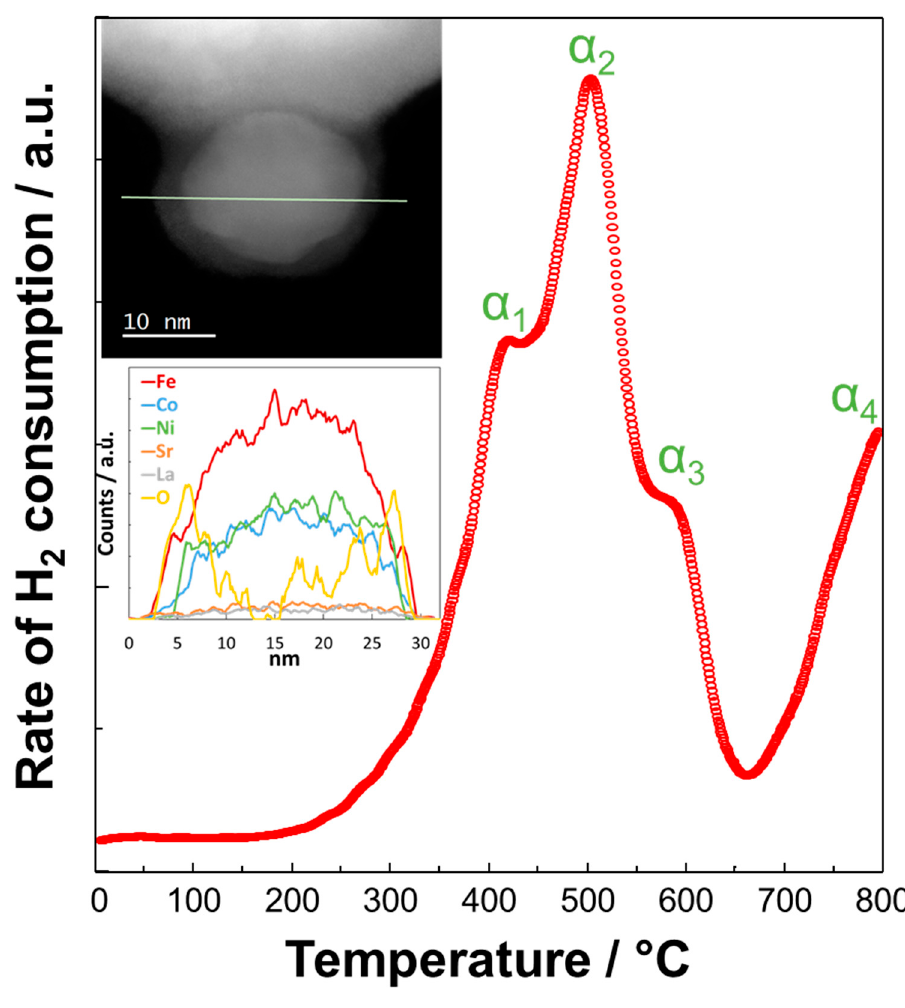
Figure 2. Temperature-programmed reduction (TPR) profile of Ni-LSFC/CGO, TEM image, and the Energy-Dispersive X-ray (EDX) measure carried out along the profile of an embedded nanoparticle on the surface of a modified perovskite. CGO: LSFC: La 0.6 Sr 0.4 Fe 0.8 Co 0.2 O 3 .